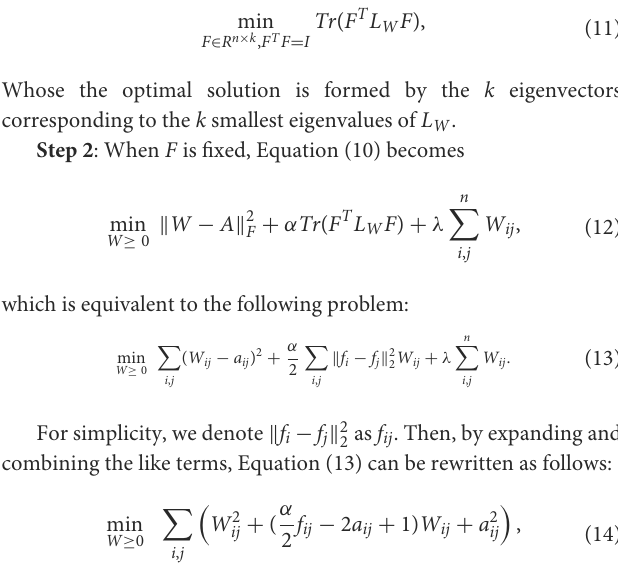
Algorithm 1. Algorithm for solving the proposed model in Equation